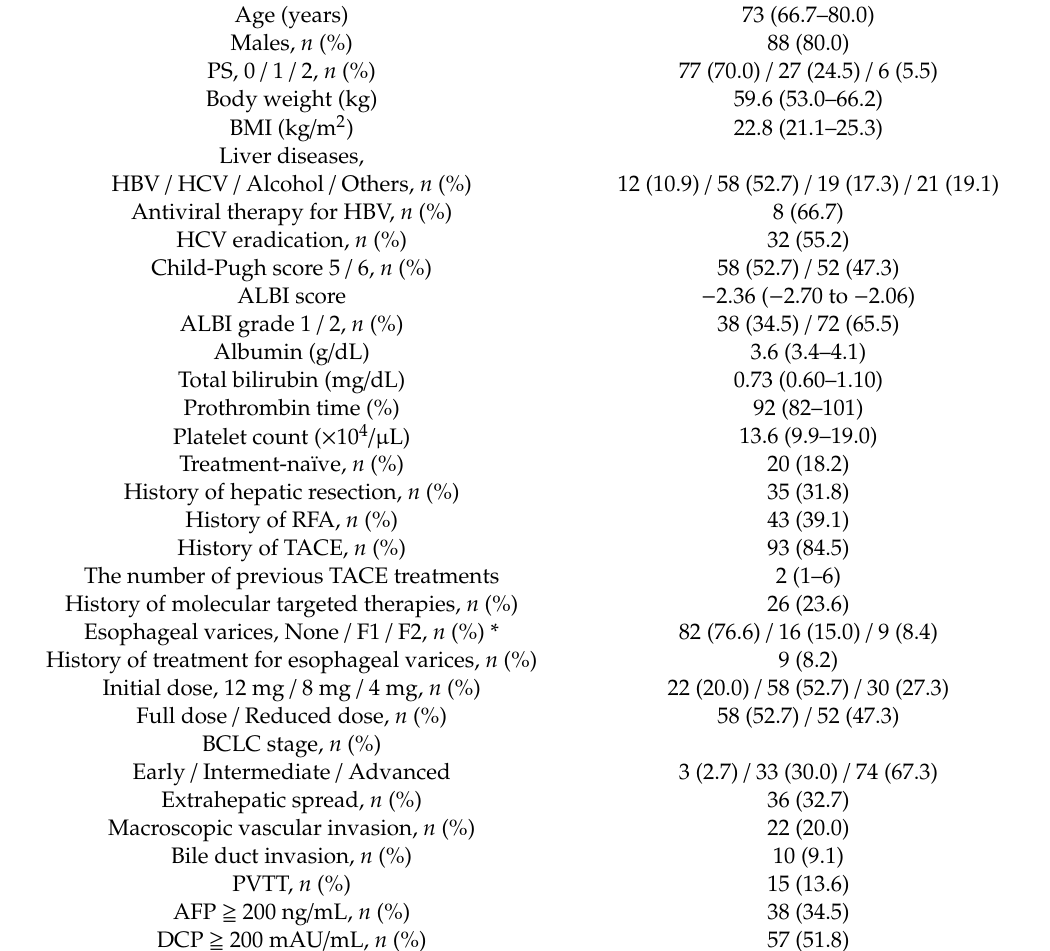
Table 1. Patient characteristics ( n =